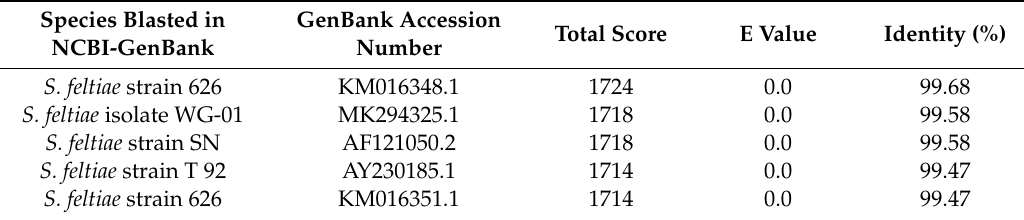
Table 1. Identification of an EPN isolate using ITS sequence. The sequence region (950 nucleotide (nt)) contains partial 18S rRNA (141 nt), ITS1 (276 nt), 5.8S rRNA (154 nt), ITS2 (301 nt), and partial 28S rRNA (78 nt).